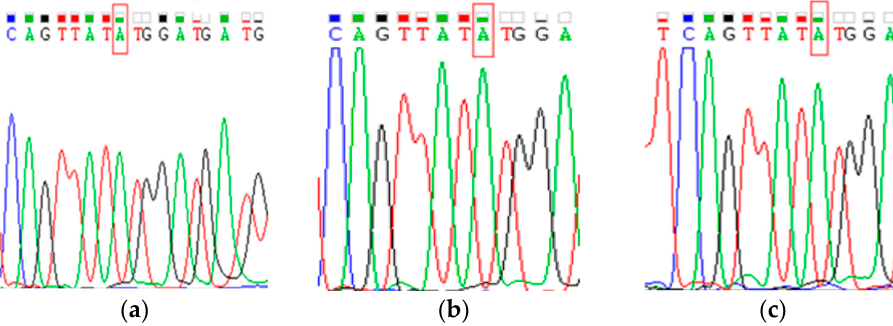
Figure 4. The results of DNA samples from patients with poor response were verified by direct sequencing. The DNA samples of ( a – c ) were extracted using the magnetic nanobeads method from the serums of patients with poor response to the nucleoside(s) treatment, and detected by the QDs- mediated fluorescent method. The results suggest that they contain the M204I mutation. The amplified products of the above three serum samples were also detected by direct sequencing, suggesting a G to A